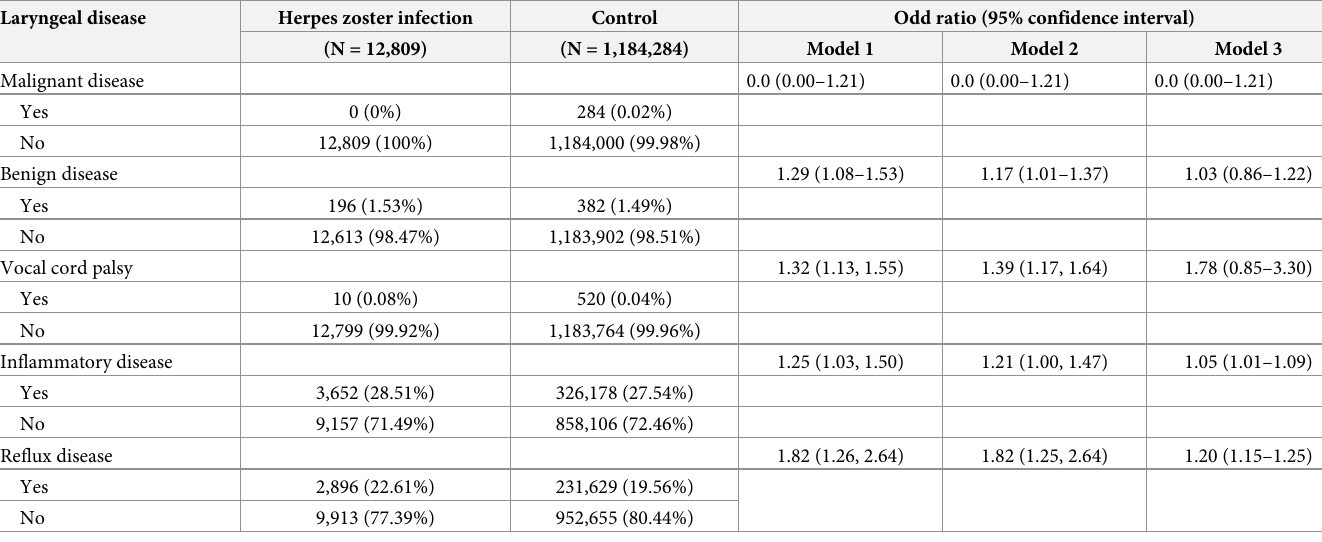
Table 3. Subgroup analysis of crude and adjusted odd ratios (95% confidence interval) of five subgroups of laryngeal diseases for herpes